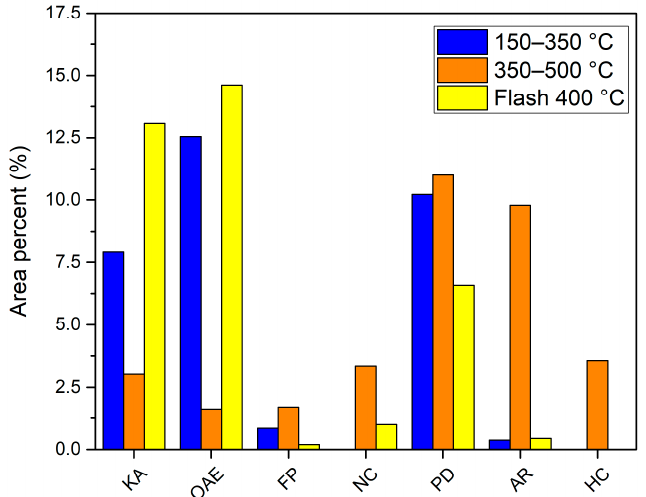
Figure 6. Comparison of area percentages for the different functional groups.